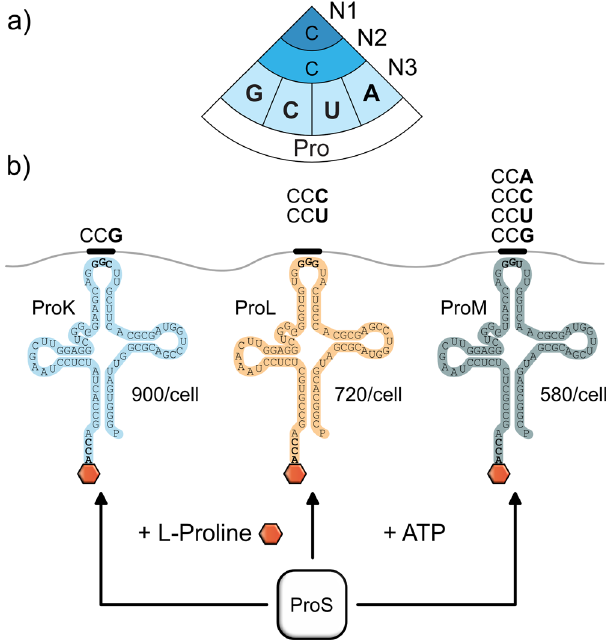
Fig. 1 Diversity of proline codons and their corresponding tRNAs. a The genetic code contains four codons for proline: CCG, CCC, CCU, and CCA. b The three tRNAs ProK, ProL, and ProM recognize distinct sets of proline codons and exhibit different levels of abundance within the cell 34 . All three prolyl-tRNAs are charged by the prolyl-tRNA synthetase